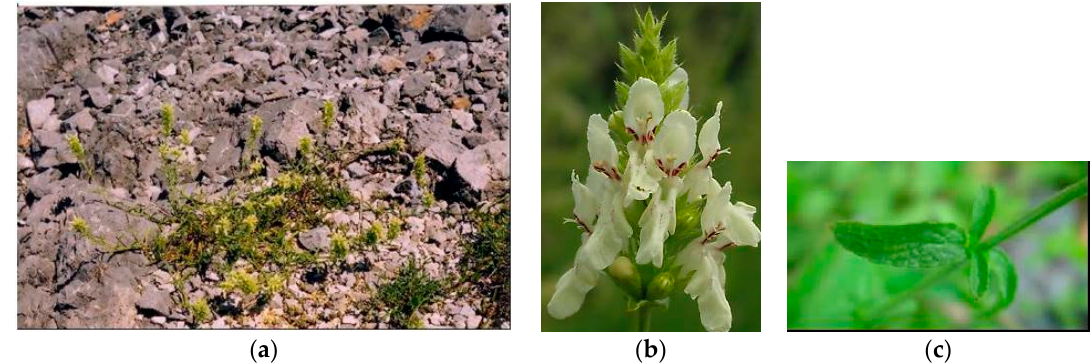
Figure 5. S. recta L. subsp. subcrenata ( a ) plant in flowering stage; ( b ) detail of the flower; ( c ) detail of leaf.